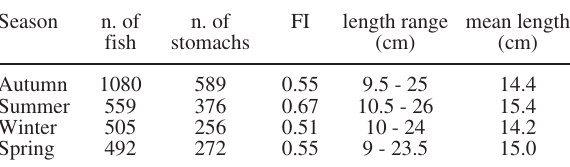
Table 1. – Number of fish samples and stomach contents collected during the four sampling periods. For each season the value of the stomach fullness (FI), the length range and the mean standard length of the collected samples are reported.